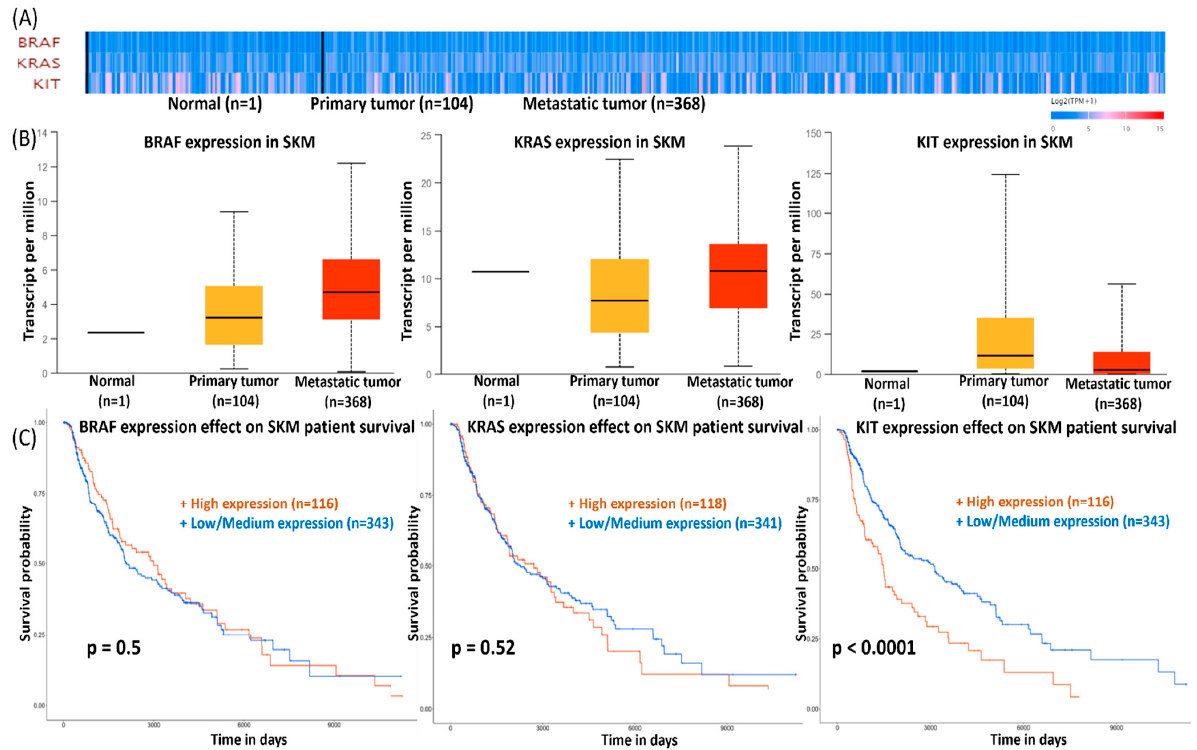
Figure 2. Expression level and prognostic significance of KRAS , BRAF , and KIT using UALCAN database: ( A ) heatmap representation; ( B ) expression level in primary and metastatic disease (TCGA samples); ( C ) survival curves comparing patients with KRAS, BRAF, and KIT high (red) and low (blue) expression in melanoma. Only KIT expression shows independent prognostic value.